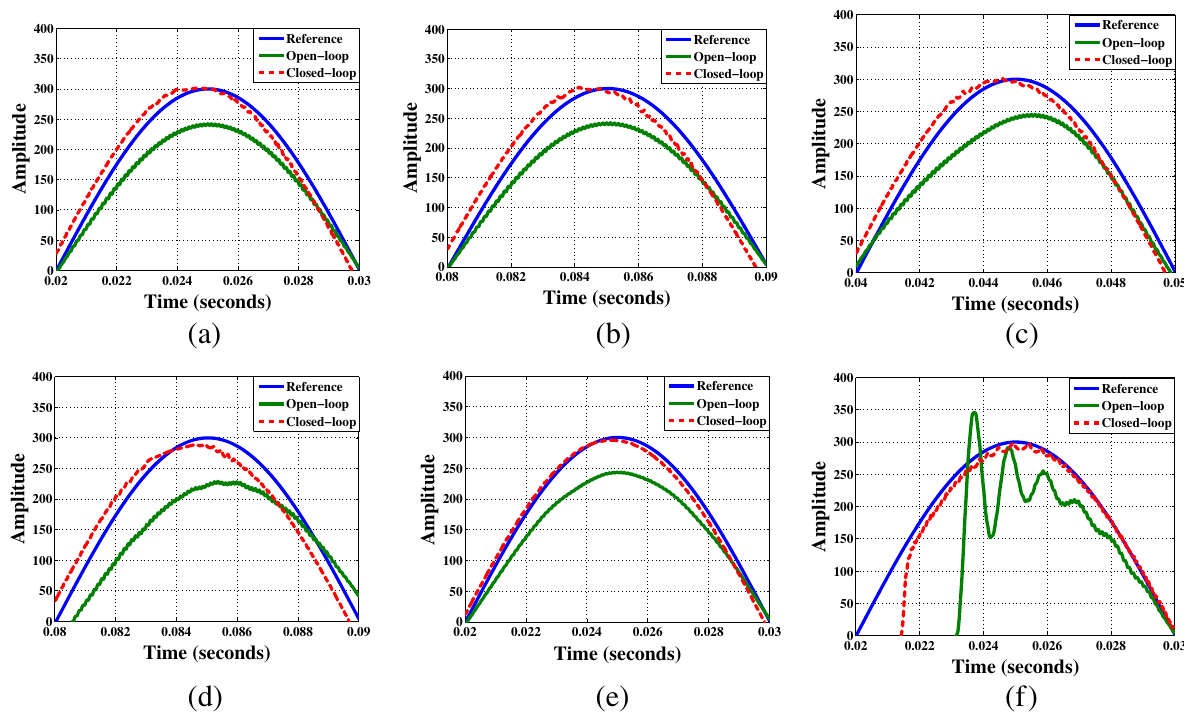
Fig. 19 Grid Voltage Tracking Using Damping Controller Under ( a ) Consumer Load, ( b ) Dynamic Load, ( c ) Harmonic Load, ( d ) Asynchronous Machine Load, ( e ) Unknown Load model, ( f ) Non-linear Load. The Green (-) and Blue (-) Solid Line Represents Response of G s ( s ) and Reference Signal Respectively, While Red (- -) Dashed Line Represents the Response of G ( s )